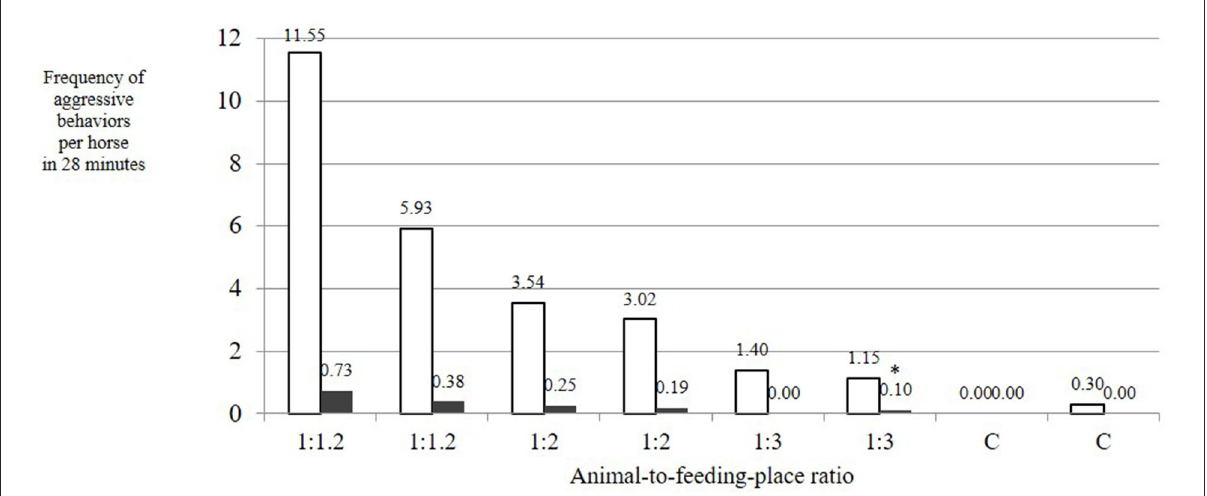
FIGURE4 Frequency of aggressive behaviors per horse during a 28-min feeding phase at time-controlled hay racks with a varying animal-to-feeding-place ratio (1:1.2 = 20% more feed-through openings than horses; 1:2 = twice as many openings as horses; 1:3 = three times as many openings as horses; C = single feeding as a control; white bars = aggressive behaviors with low risk of injury; dark bars = aggressive behaviors with high risk of injury). Influence of AFR on the number of aggressive behaviors with low risk of injury: LMM, F (3,4) = 7.268; adjusted R 2 = 0.729; p = 0.04. Influence of AFR on the occurrence of aggressive behaviors with high risk of injury: LMM, F (3,4) = 7.411; adjusted R 2 = 0.733; p = 0.04, p (AFR_1 : 3) = 0.02, p (AFR_C) = 0.01.